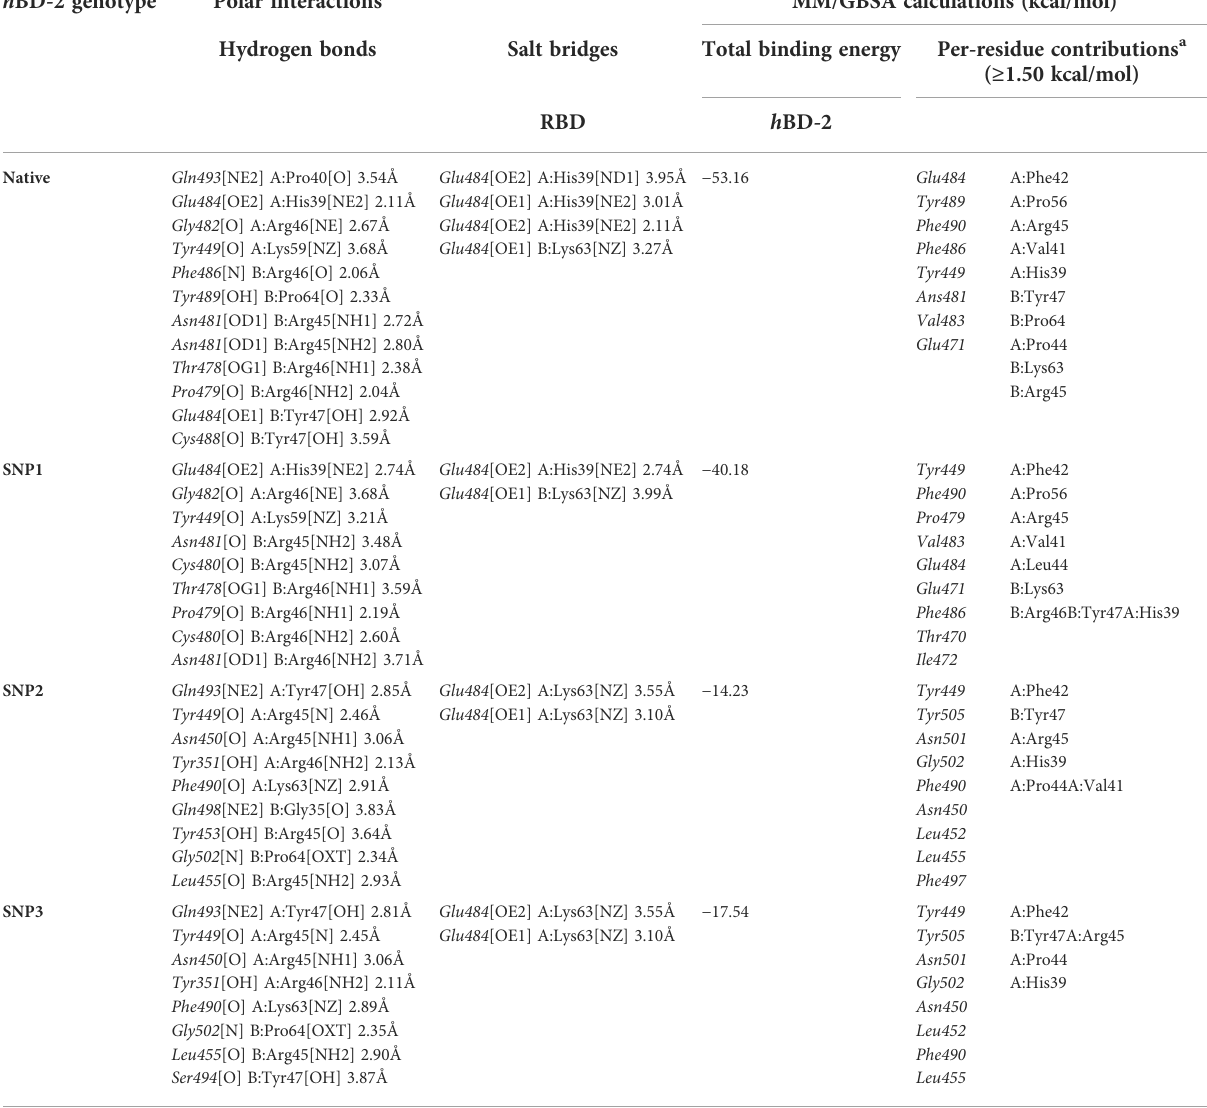
TABLE 6 Key interface per-residue polar interactions via PDBePISA and predicted MM/GBSA binding energies. h BD-2